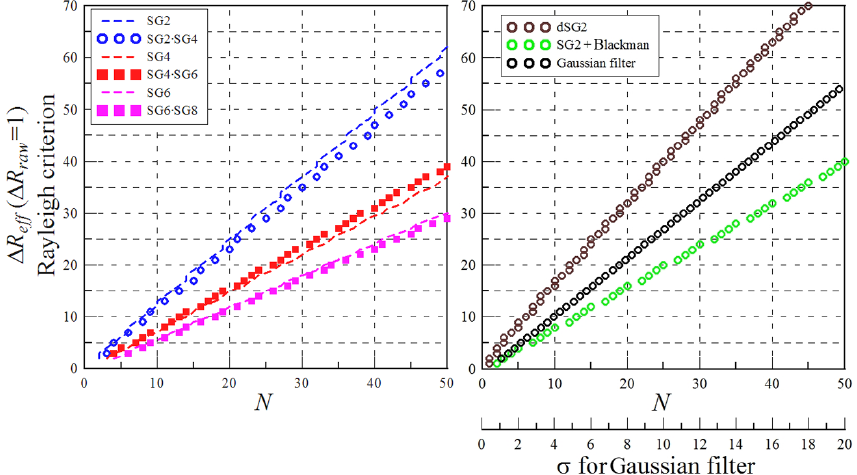
Figure 10. Left panel: the ERes estimated with the Rayleigh criterion applied to SG filters up to order P = 6 as a function of N . For all the polynomial orders examined (2, 4, 6), small differences ( ≤ 5–10%) in the ERes are found between the results obtained applying the criterion on SG filter and the corresponding “equivalent” cascade filters. Right panel: the ERes obtained for three different low-pass filters (dSG2, SG2 + Blk, Gaussian) for which the application of Rayleigh criterion does not show anomalous